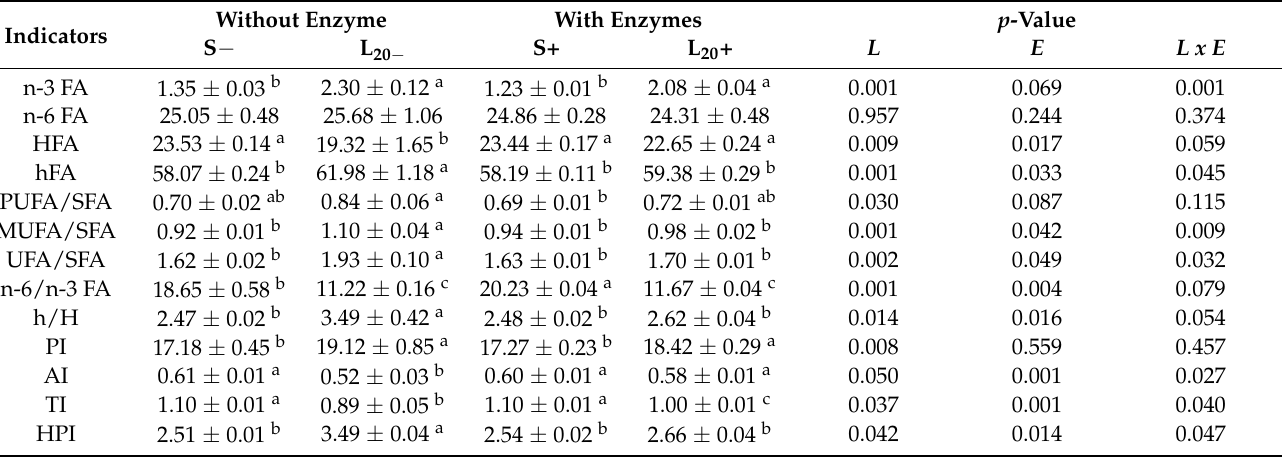
Table 10. Influence of enzymes addition in lupine-based diets on the lipid quality indices of the fats from egg